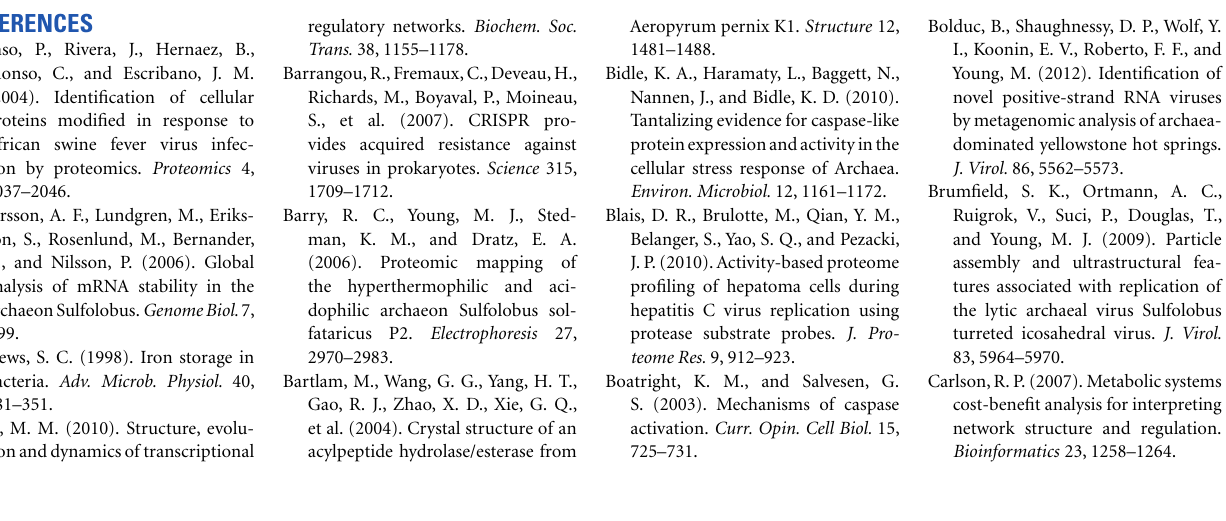
Table S1 | Regulated S. solfataricus (P2) proteins. Table S2 | Sulfolobus pathways. Table S3 | Identified proteins from phospho-stained spots. Table S4 | IdentifedABPP labeled